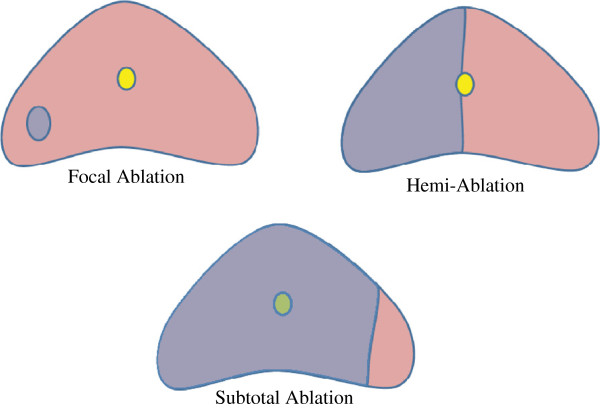
Schematic depicting ‘focal’cryoablation. Ablation can be of single target lesion, of specific side of prostate harboring the cancer or of nearly the entire gland but sparing the posterior lateral aspects were caversonal resides.